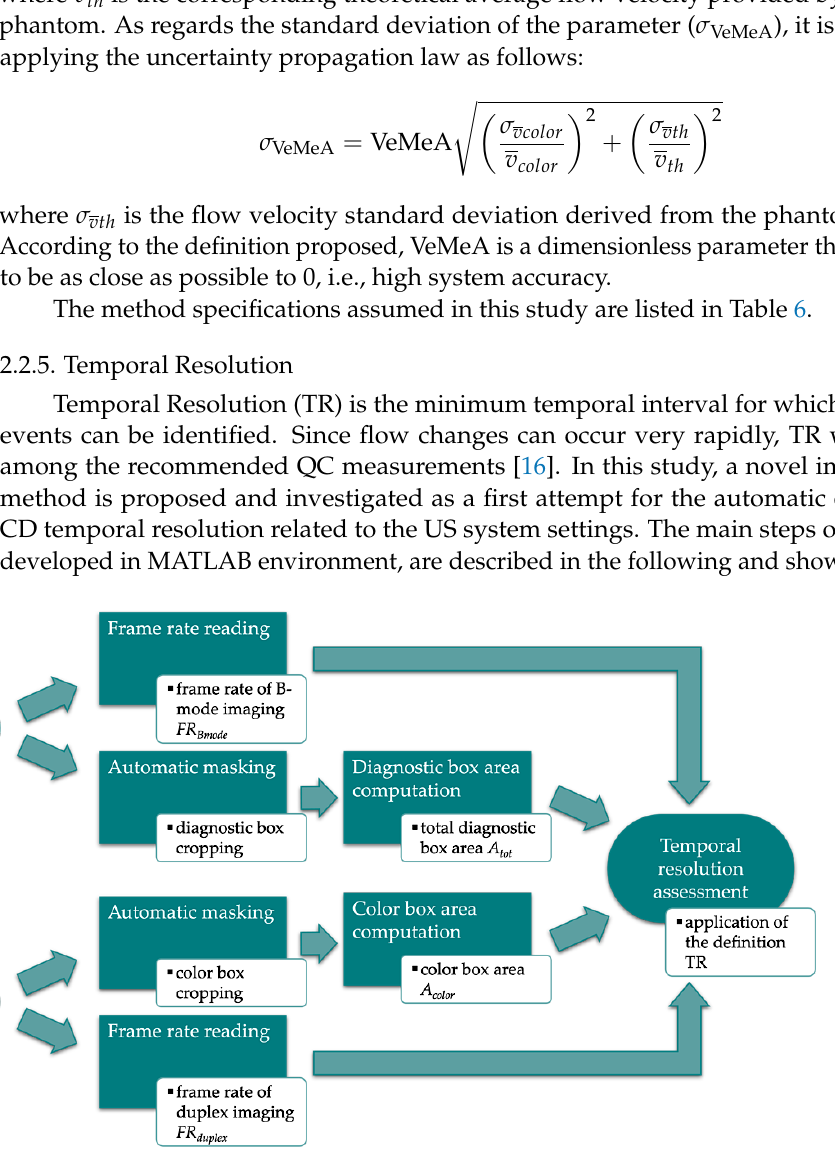
Figure 9. Flow chart of the image analysis-based method for temporal resolution parameter estimation.